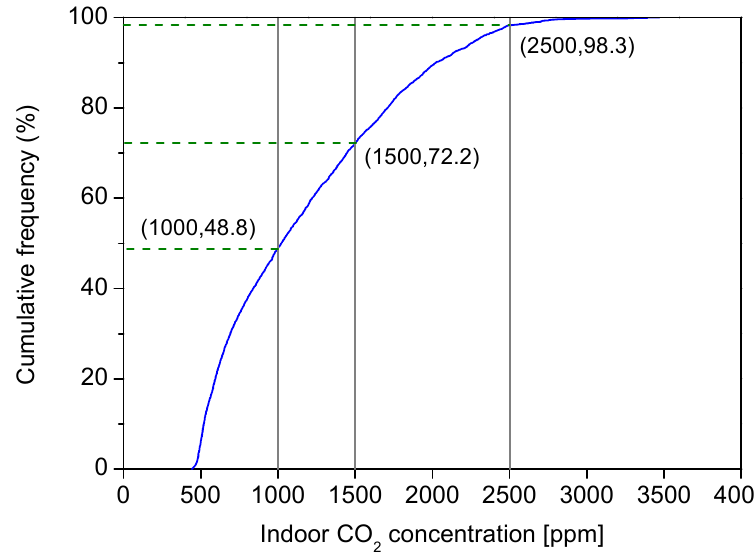
Figure 7. Cumulative frequency of indoor CO 2 concentration during monitoring period. Figure 8 summarizes the time of indoor CO 2 level over 1000 ppm each day. As a